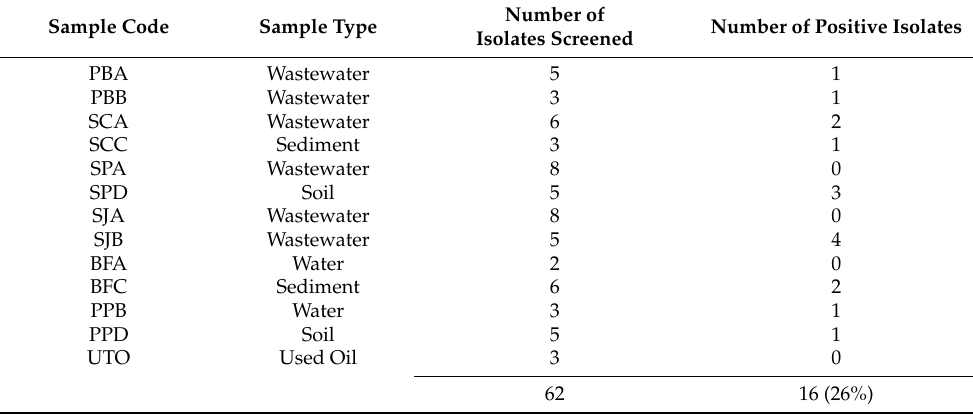
Table 2. Nile red PHA screening response of the used transformer oil-degrading